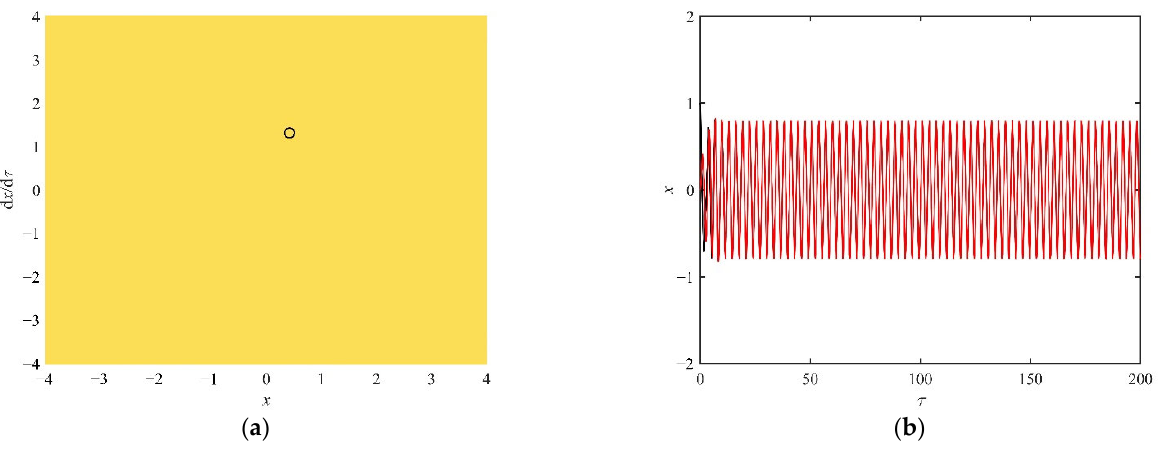
Figure 8. ( a ) The distribution of attractors without the frequency island; ( b ) the time history of vibration, the initial conditions of black line, are selected as ( 1,0 ) , the initial conditions of red line are selected as ( 0,0 )